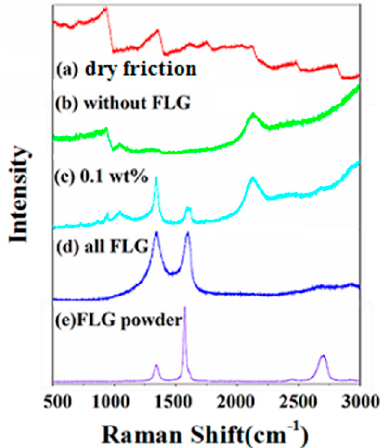
Figure 6. Raman spectra of the rubbing surfaces of the Si 3 N 4 disks. ( a ) Without any lubrication; ( b – d ) lubricated by Mdol containing different contents of FLG; ( e ) FLG powder.